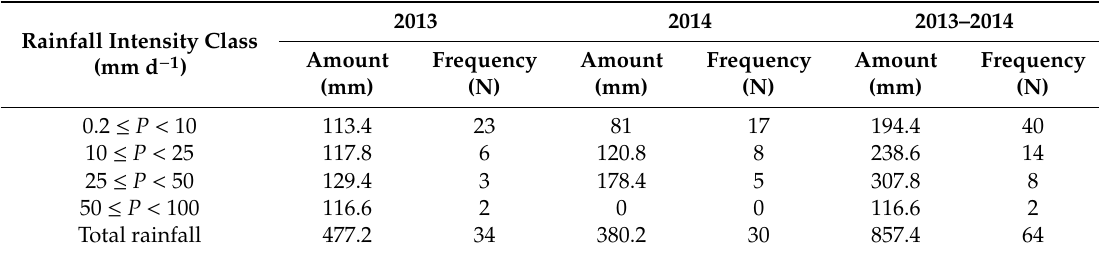
Table 3. The total rainfall from May to September of 2013–2014 according to four rainfall classes. Rainfall Intensity Class